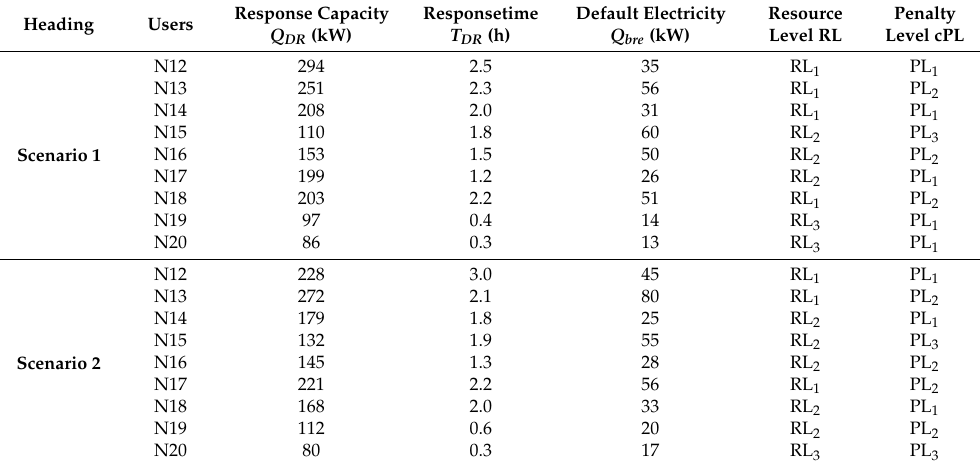
Table 3. The response characteristics of DR in different scenarios.